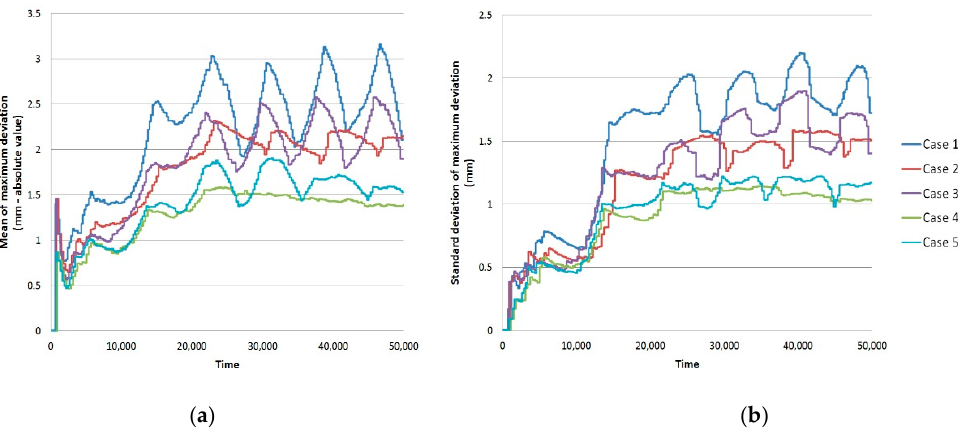
Figure 11. Statistical analysis of maximum deviation detected at final inspection (Stage_4). ( a ) Mean; ( b ) standard deviation.